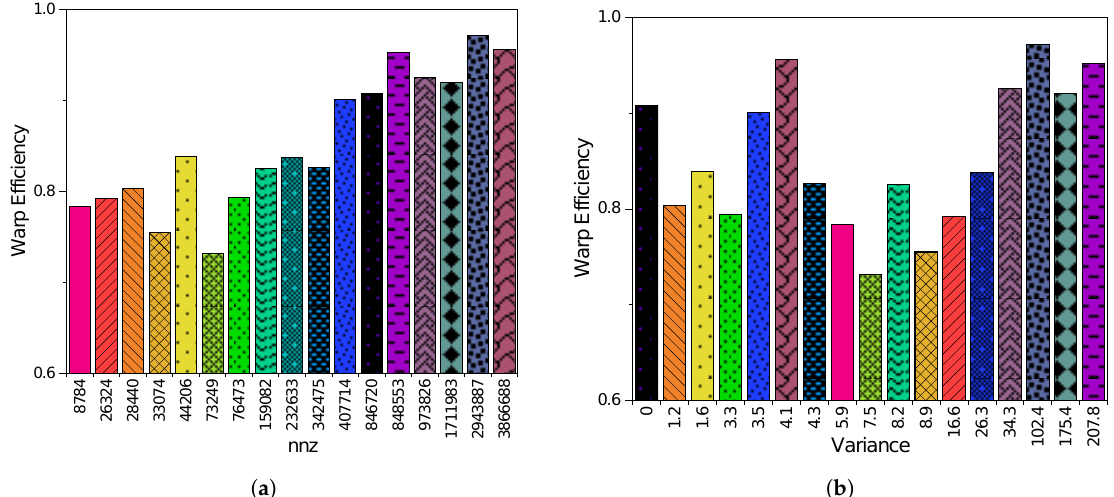
Figure 20. CSR5 warp efficiency against: ( a ) nnz and ( b ) npr variance